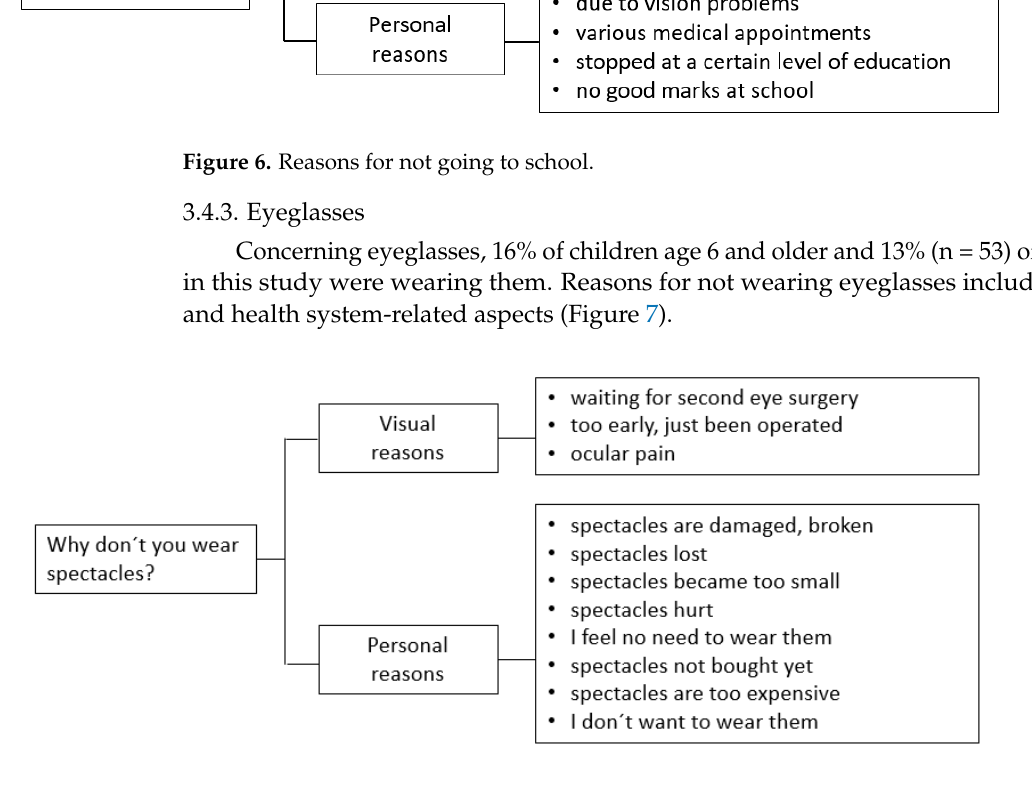
Figure 7. Reasons for not wearing eyeglasses.